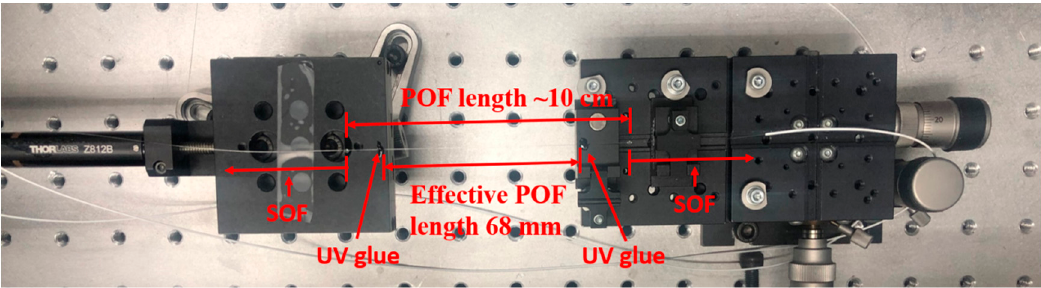
Figure 5. M–Z interferometer configuration for strain application. The effective POF length is 68 mm.